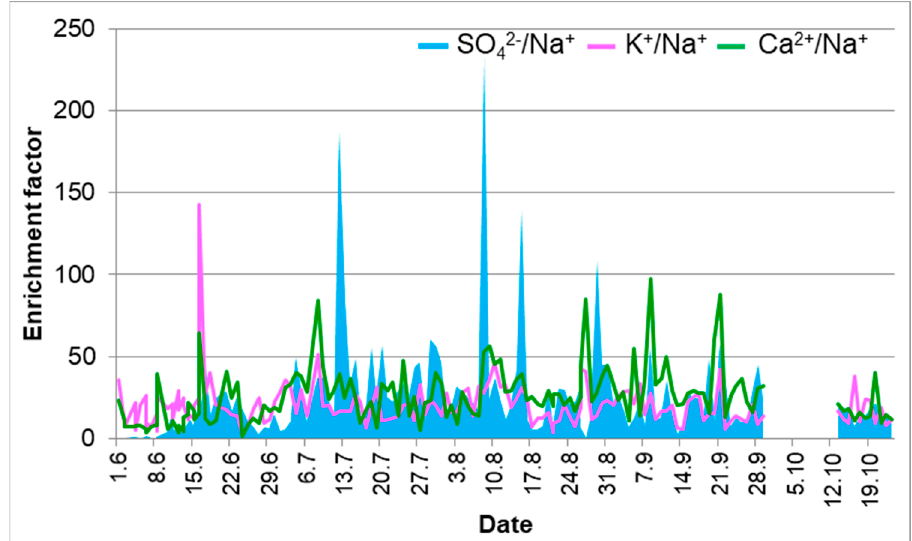
Figure 5. Enrichment of aerosol particles in potassium ions, sulfate ions and chloride ions at the Bolshiye Koty research station (summer and autumn 2020).